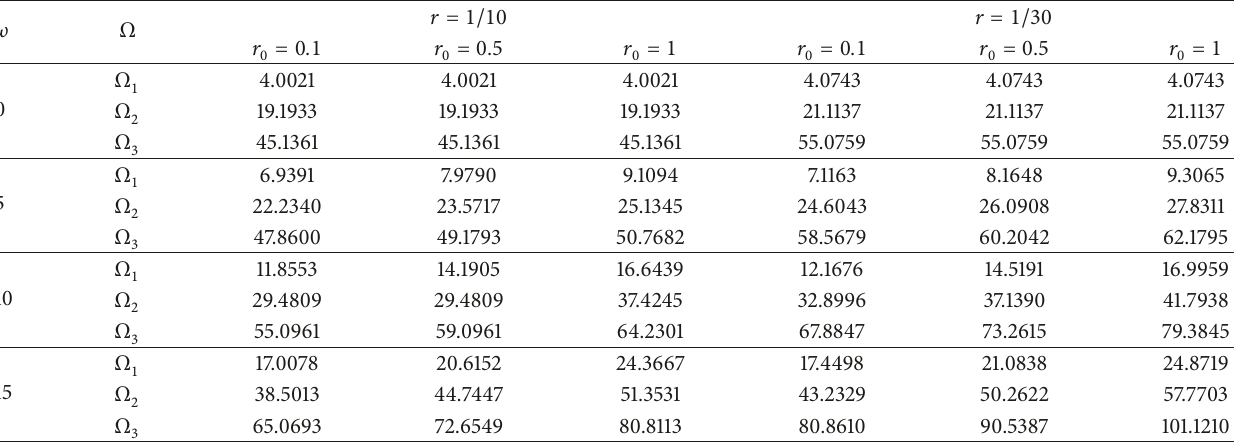
Table 6: The first three-order dimensionless natural frequencies of rotating tapered hollow beams for various ratios of hub radius to beam length 𝑟 0 (𝛽 = 0.2)